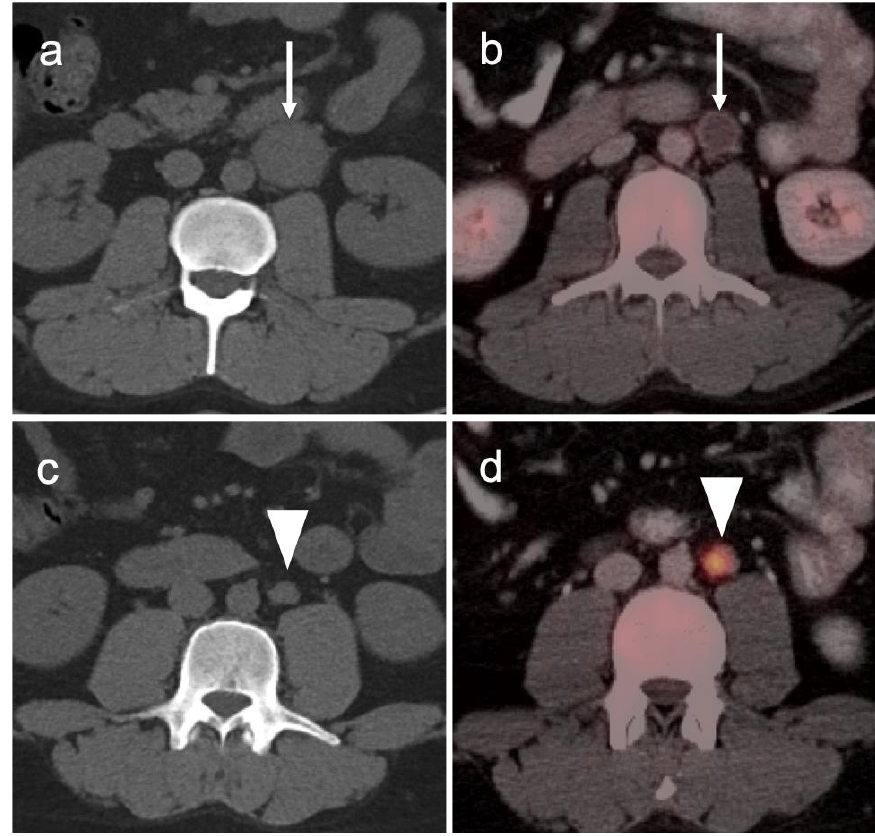
Figure 44. A pure seminoma with retroperitoneal metastases showing a variable response to treatment is shown on a pre-treatment CT (left, a , c ) and a post-treatment FDG PET-CT (right, b , d ). Pre-treatment CT ( a ) shows a sizable retroperitoneal mass (white arrow) that undergoes a decrease in size and attenuation, as well as an absence of metabolic activity on post treatment FDG PET-CT ( b ), white arrow); However, a more inferior additional left periaortic nodule ( c , white arrowhead) on the pre-treatment CT shows an interval increase in size as well as significant metabolic on the post-treatment FDG PET-CT ( d , white arrowhead), consistent with tumor progression.